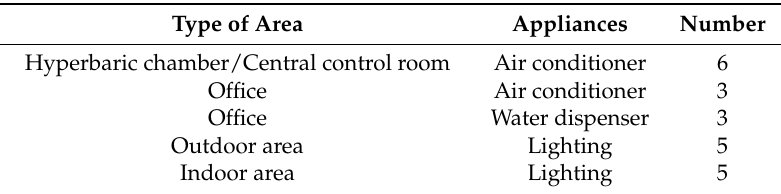
Table 3. Electrical appliances in the pilot